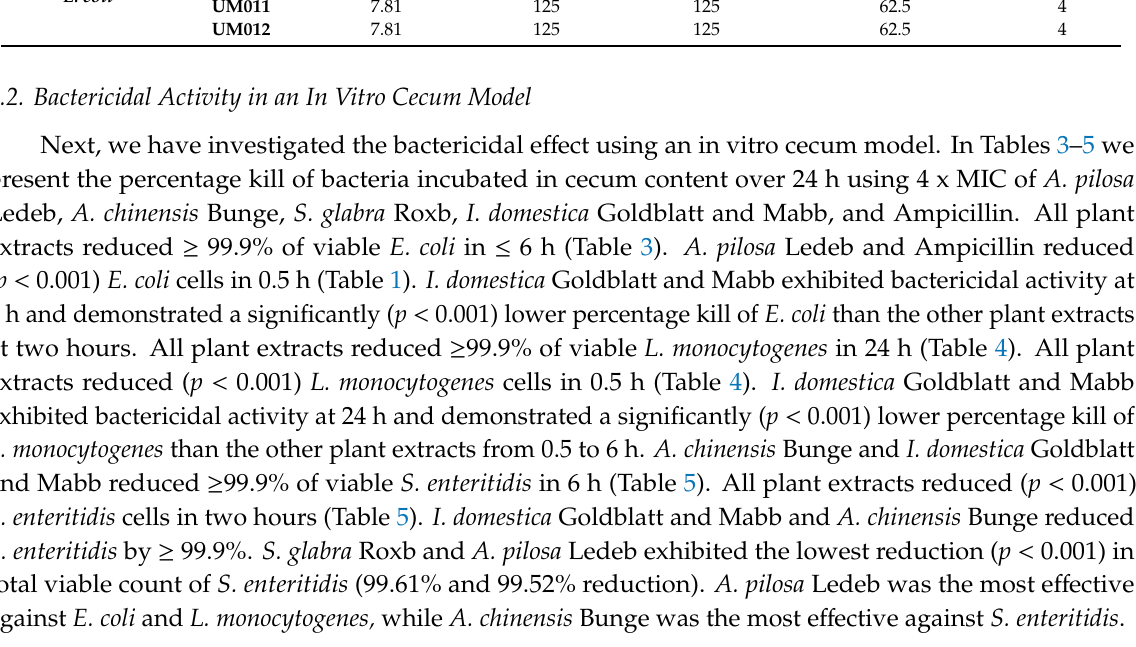
Plant Extract Smilax glabra